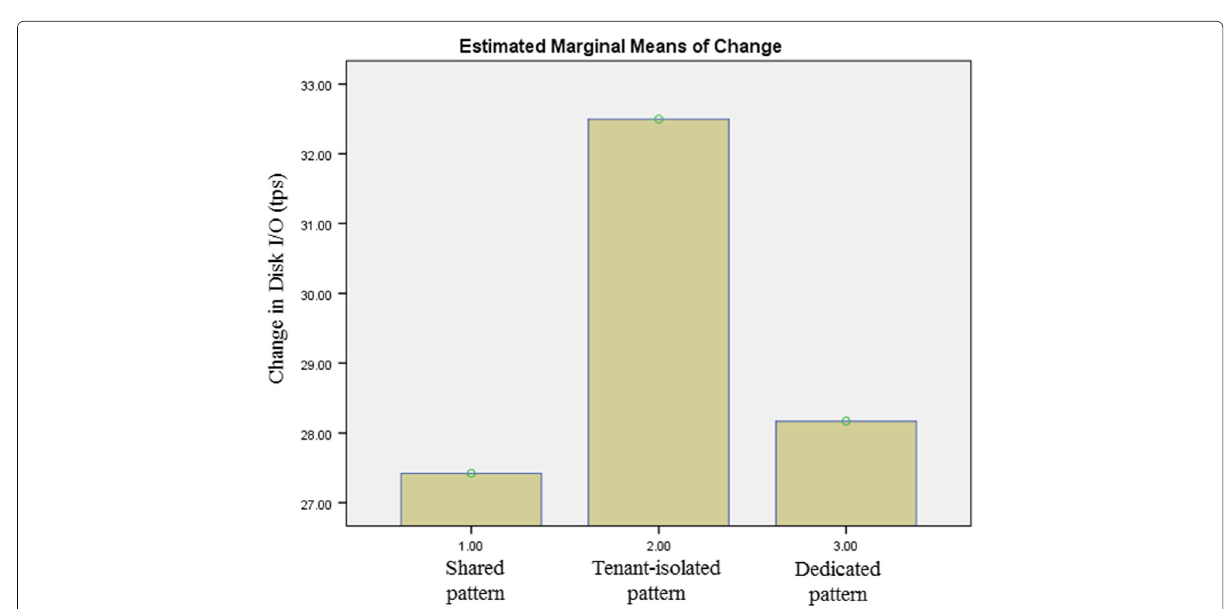
Fig. 20 Changes in Disk I/O